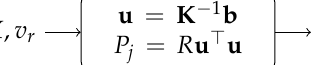
Figure 8. Model of the